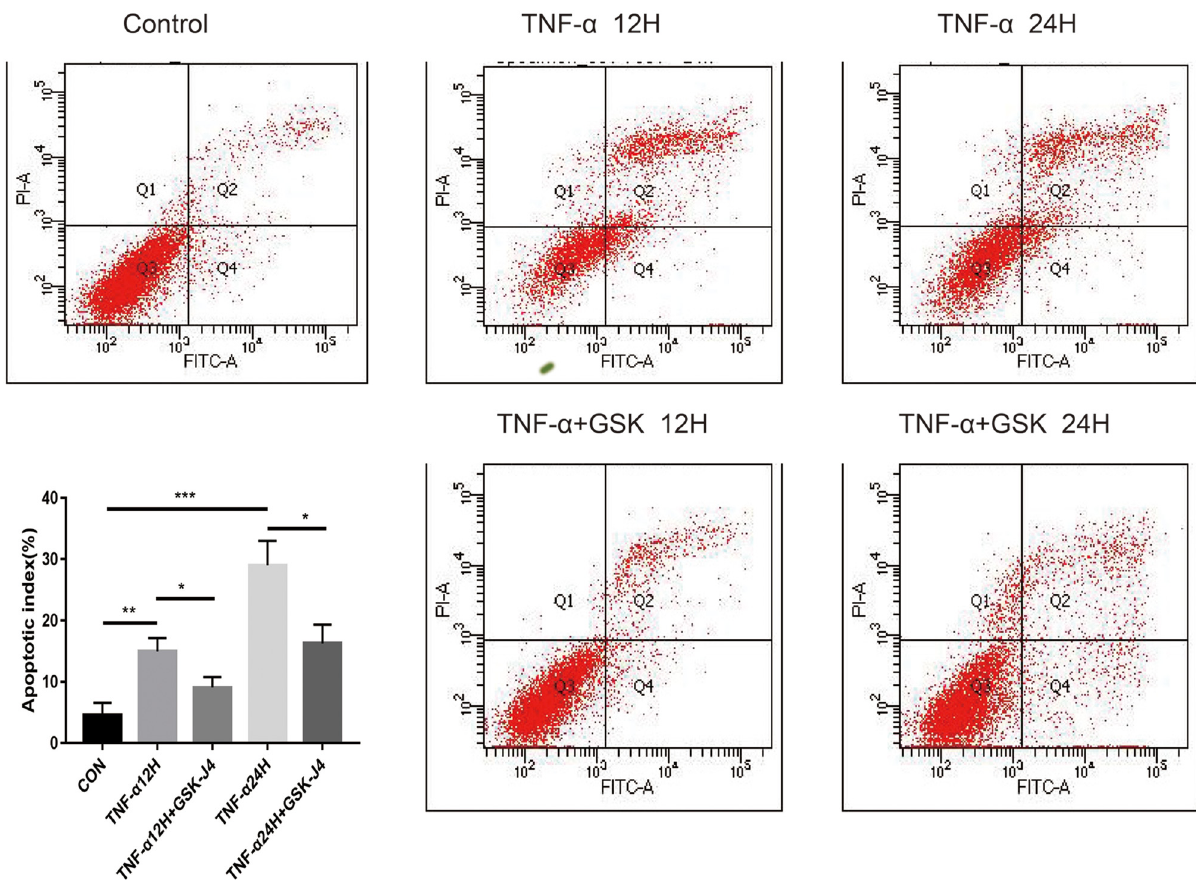
Figure 5: The impact of GSK - J4 on thyroid cells apoptosis with the stimulation of TNF - α . * P < 0.05, ** P < 0.01, *** P < 0.001 vs